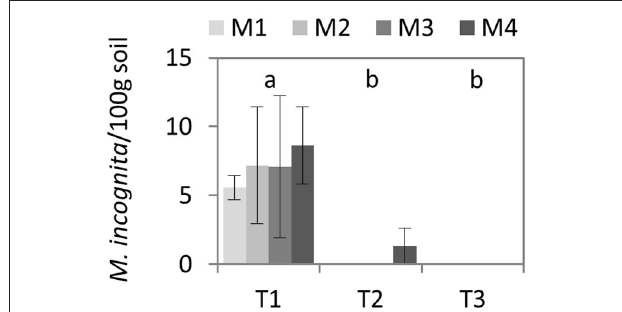
FIGURE 1 | Average and standard errors of the number of juveniles of Meloidogyne incognita quantified in 100g dry soil. Values of the four biodisinfestation treatments (M1, M2, M3, M4) are shown before biodisinfestation (T1), after biodisinfestation (T2) and after harvesting the first crop after treatments (T3). No statistical differences ( P ≤ 0.05) were obtained among treatments. Letters indicate the significant differences among times according to Tukey HSD test ( P ≤ 0.05).